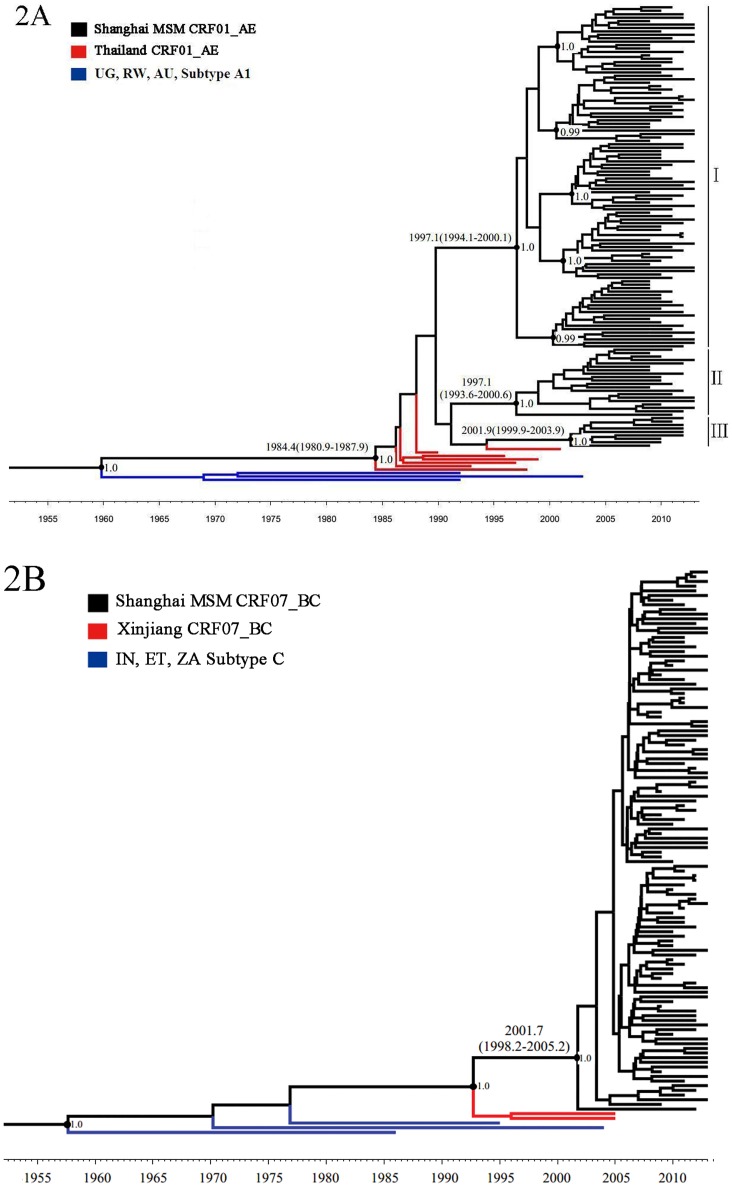
Maximum clade credibility (MCC) trees representing the rooted genealogy of CRF01_AE and CRF07_BC among MSM in Shanghai.2A: the MCC tree for CRF01_AE strain. HIV-1 A1 sequences from Uganda(UG), Rwanda(RW), Australia(AU) and HIV-1 CRF01_AE sequences from Thailand (TH) were used as the references, including UG.92.AB253429, AU.03.DQ676872, RW.92.AB253421, TH.93.051, TH.90.U54771, TH.96.02138, TH.97.1695, TH.98.1251, TH.99.4460, and TH.01.2570. Blue lines represent A1 from UG, RW, AU and red lines represent CRF01_AE from TH. I, II, and III represent three clusters belonging to CRF01_AE strain. 2B: the MCC tree for CRF07_BC strain. HIV-1 subtype C sequence from Indian (IN), Ethiopia (ET), South Africa (ZA), and CRF07_BC sequence from Xinjiang, China (CNEF) were used as the reference, including IN.95.21068, ET.86.368370, ZA.04.AY772699, CNEF.05.368370, CNEF.05.368372. Blue lines represent subtype C from IN, ET, ZA and red lines represent CRF07_BC from CNEF. The branch lengths in the MCC tress reflect time and corresponding time-scale is shown at the bottom of the trees. Both the posterior probabilities and the tMRCA for the key nodes are indicated.